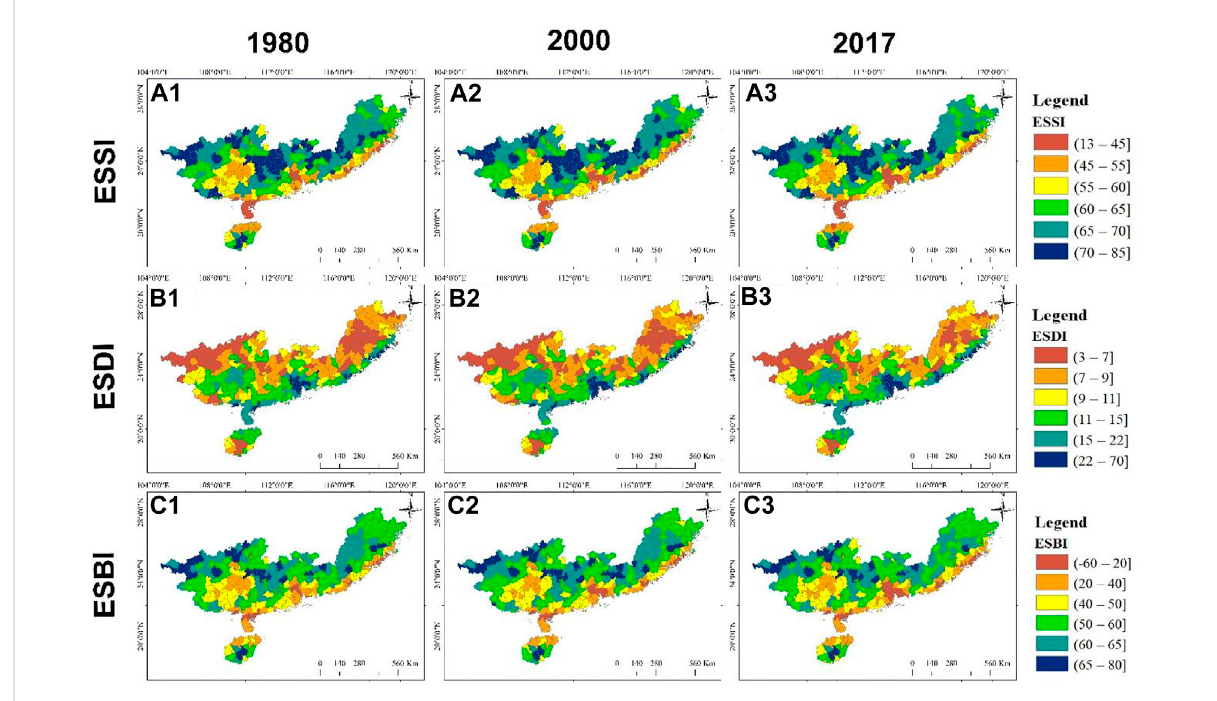
FIGURE 4 Spatial evolution of the (A) ESSI, (B) ESDI, and (C) ESBI of the south-eastern coastal region of China for the three periods of 1980, 2000, and